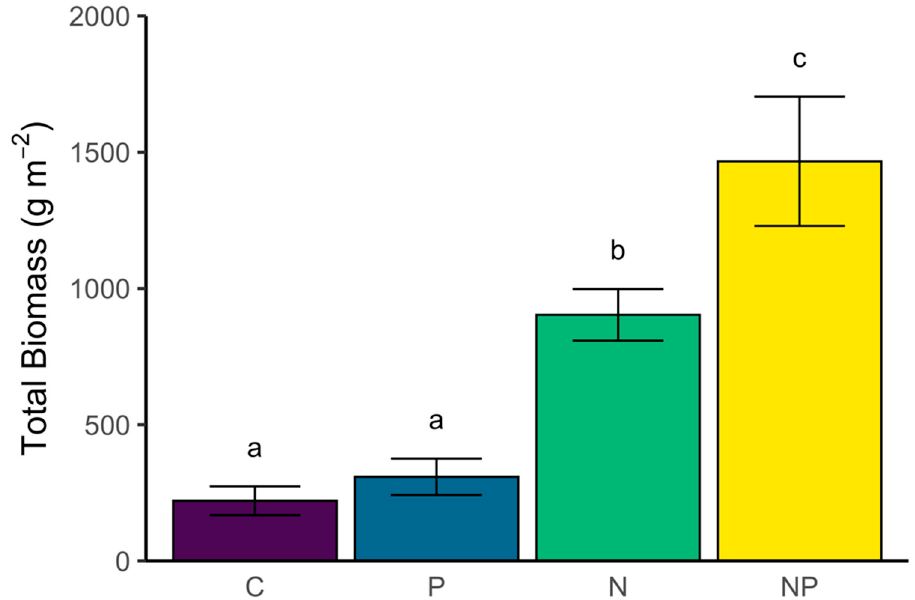
Figure 1. Total biomass (mean ± SE) for each nutrient treatment (C = control, P = phosphorus, N = nitrogen, and NP = nitrogen + phosphorus) on a barrier island grassland community. Letters indicate significant differences based on Tukey HSD pairwise comparison results. Bars with different letters are significantly different ( p < 0.05).